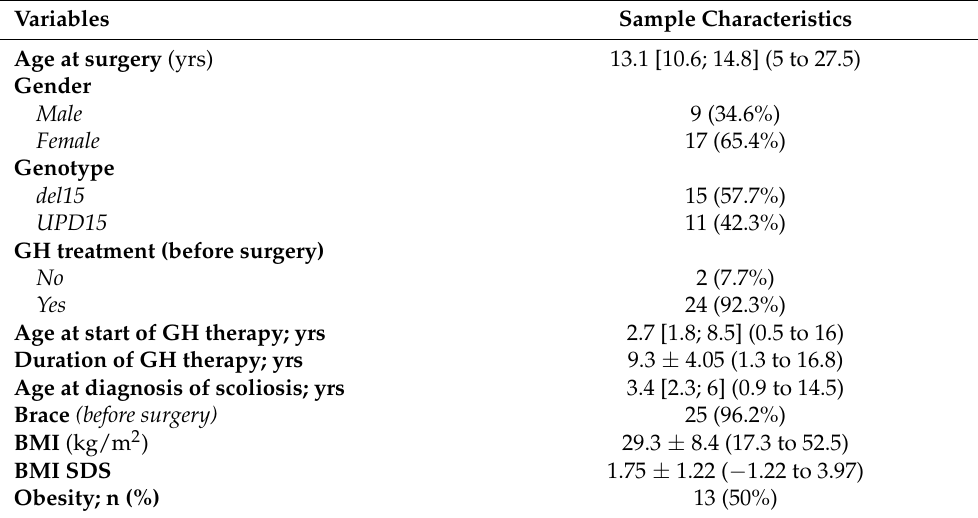
Table 5. Clinical characteristics and anthropometric measurements of 26 PWS patients who under- went